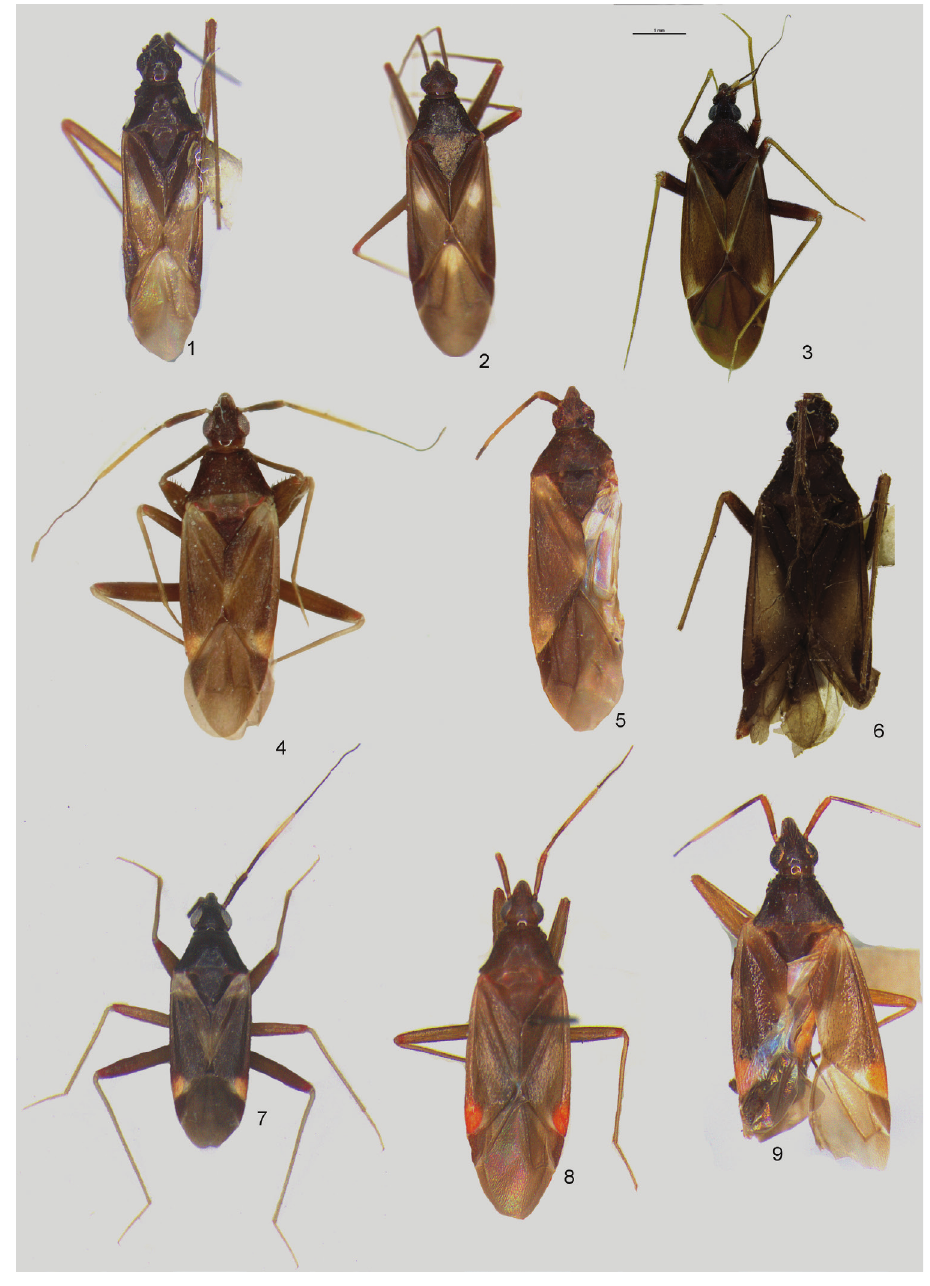
Figures 1–9. Dorsal habitus photographs of bifenestratus group of species of the genus Fulvius : 1 F. bifen- estratus ( ♂ ) 2 F. bimaculatus ( ♀ ) 3 F. constanti (paratype) 4, 5 F. flavicornis ( 4 ♂ 5 holotype); 6 F. henryi (paratype, ♀ ) 7 F. subnitens ( ♂ ) 8 F. thailandicus (holotype) 9 F. tumidipennis (paratype, ♂